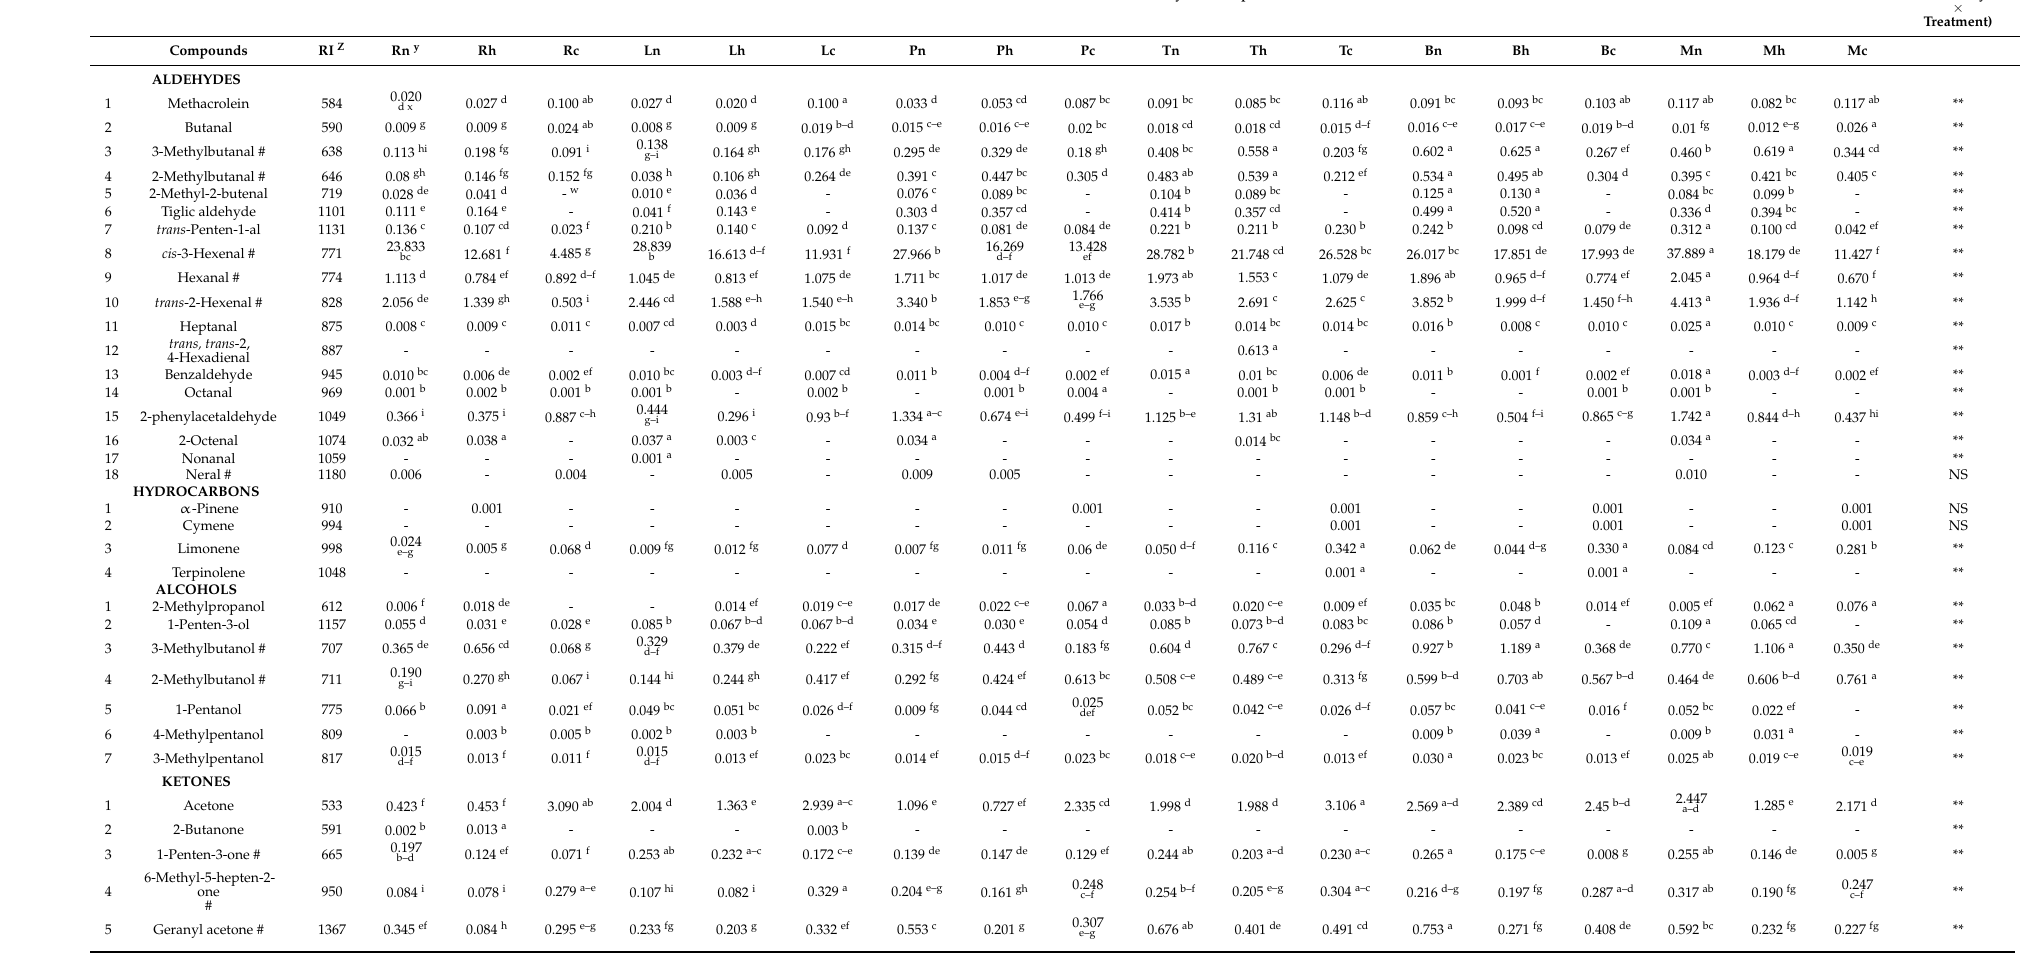
Table 1. Concentration (mg L − 1 ) of volatile compounds determined in ripe tomatoes harvested at six maturity stages and treated with refrigeration (chilling, c), blanching (heating, h), or not-treated (control,